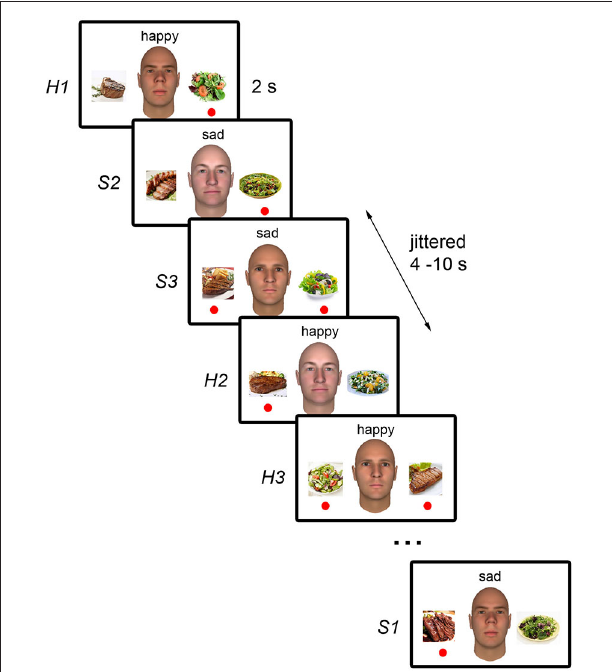
FIGURE 1 | Schematic illustration of the experimental paradigm. During each trial, the neutral face picture of one of the three white male individuals was displayed. As the NimStim faces used cannot be published, sample faces generated with FaceGen (Singular Inversions, Toronto, ON, Canada) are shown here instead. Pictures of a meat dish and a vegetable dish were presented on the left and right of the face. The word “happy” or “sad” was displayed above the face to indicate the individual’s current emotional state. Participant’s task was to indicate, using the left and right button presses, which dish the individual would choose based on the individual’s emotional state. Trials were presented for 2 s and were separated by a 4–10 s jittered interval during which a fixation cross was displayed (not shown). The red circles indicate each individual’s emotion-dependent food preferences and were not displayed during the